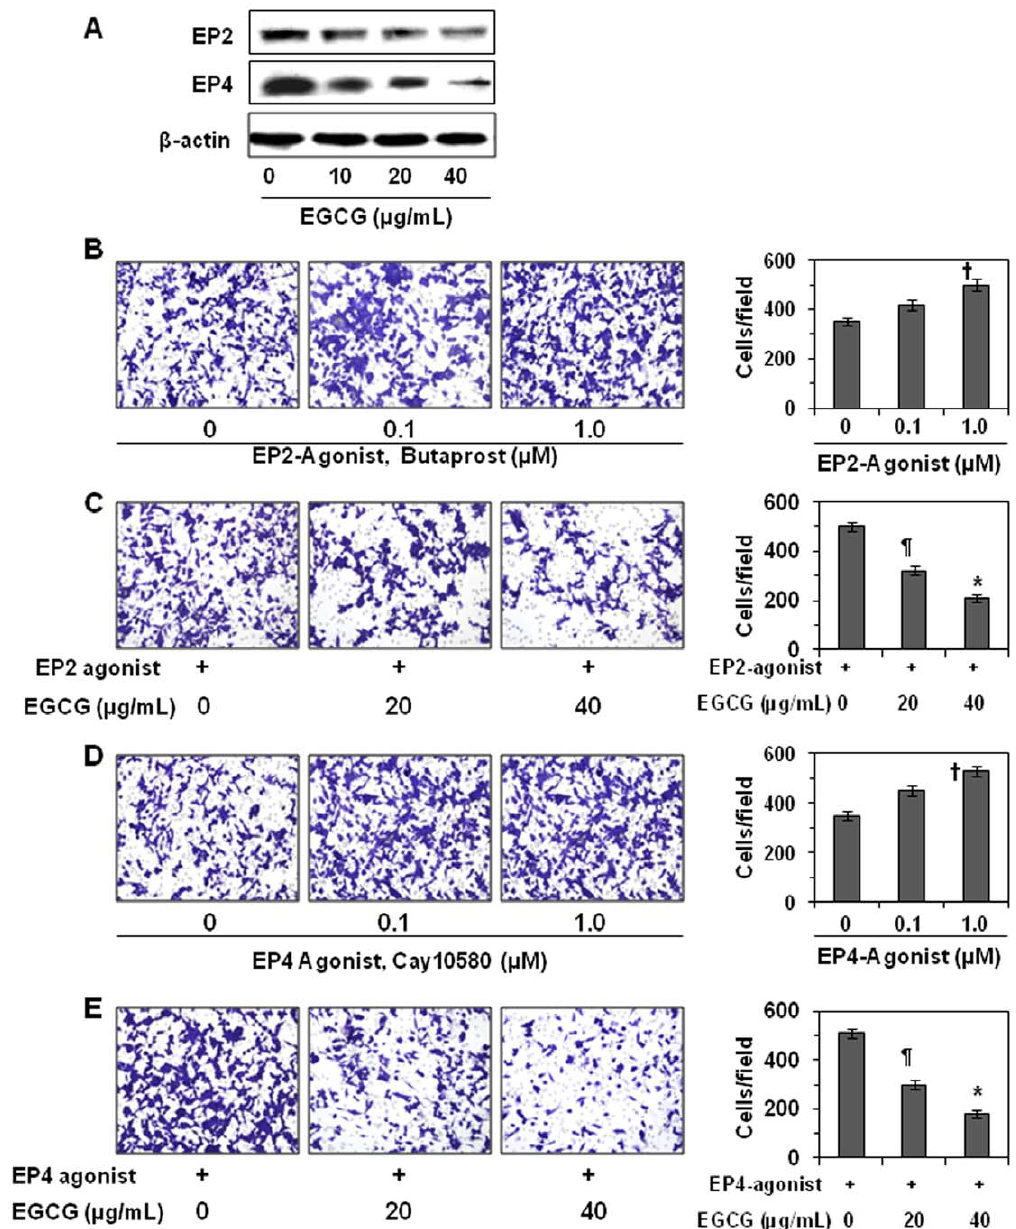
Figure 5. EGCG inhibits PGE 2 receptors-induced human melanoma cell migration. ( A ) Treatment of A375 melanoma cells with EGCG for 24 h decreases the expression levels of PGE 2 receptors EP2 and EP4 in a concentration-dependent manner. The cells were harvested 24 h after the treatment and cell lysates were prepared and subjected to western blot analysis, as detailed in Materials and Methods. ( B ) Treatment of A375 cells with EP2 agonist (butaprost) for 24 h enhances melanoma cell migration (left panels). The data on cell migration are summarized and expressed as a mean number of migratory cells 6 SD/microscopic field, n=3 (right panel). ( C ) Treatment of A375 cells with EGCG inhibits EP2 agonist (1.0 m M)- induced melanoma cell migration (left panels). The data on cell migration are summarized as a mean number of migratory cells 6 SD/microscopic field, n=3 (right panel). ( D ) Treatment of A375 cells with EP4 agonist (Cay10580) for 24 h enhances cell migration (left panels). The data on cell migration in each group are expressed as a mean number of migratory cells 6 SD/microscopic field, n=3 (right panel). ( E ) Treatment of A375 cells with EGCG inhibits EP4 agonist (1.0 m M)-induced cell migration (left panels). The data on cell migration are summarized as a mean number of migratory cells 6 SD/microscopic field, n=3 (right panel). Representative photomicrographs of cell migration were presented from three independent experiments in each case. Significant inhibition versus non-EGCG-treated controls, " P , 0.01; * P , 0.001; Significant increase versus non- EP2 agonist-treated or non-EP4 agonist-treated controls, { P , 0.001. doi:10.1371/journal.pone.0025224.g005 EGCG in a concentration-dependent manner (Figure 6B). The revealed that treatment of cells with EGCG decreased the results also indicated that treatment of EGCG resulted in the translocation of NF- k B/p65 in to the nucleus in a dose-dependent downregulation of IKK a and degradation of I k B a (Figure 6A), manner (Figure 6A). The activity of NF- k B also was significantly which leads to the inactivation of NF- k B and its translocation to reduced (20–65%, P , 0.001) after the treatment of cells with